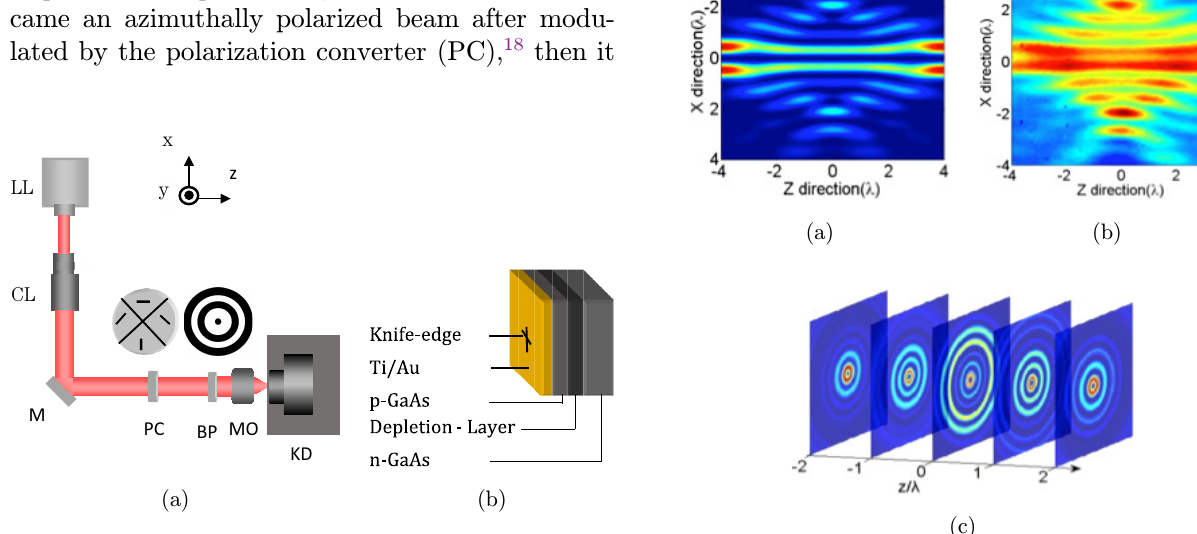
Fig. 2. Schematic experiment setup. (a) LL, linear polarized laser; CL, collimating lens; M, mirror; PC, polarization con- verter; BP, binary optics; MO, microscope objective (NA ¼ 0.95); KD, knife-edge detector set on a nanometer-platform (gray region). (b) The cross-shaped knife-edge detector.